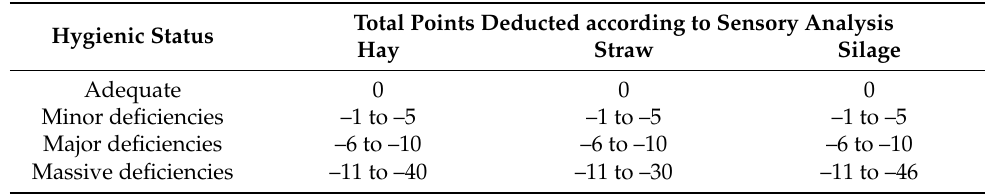
Table 2. Determining sensory score on the basis of points deducted in sensory analysis in accordance with Kamphues et al. [8].